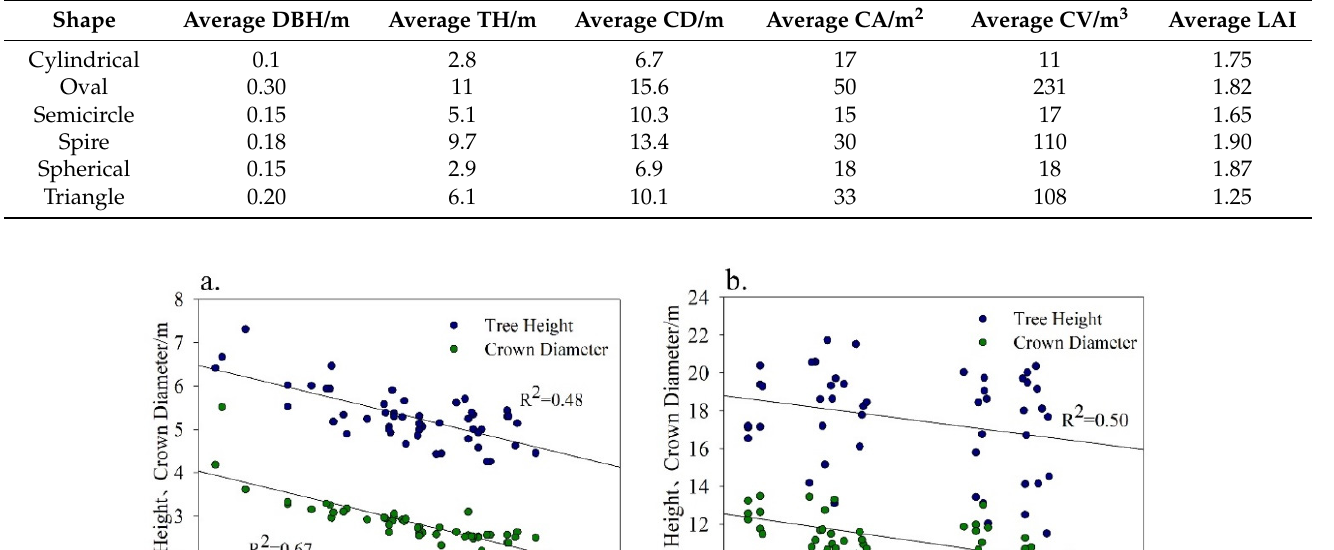
Table 5. Morphological structure characteristics of different tree shape.